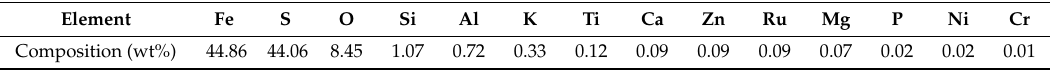
Table 1. Chemical analysis for the pyrite